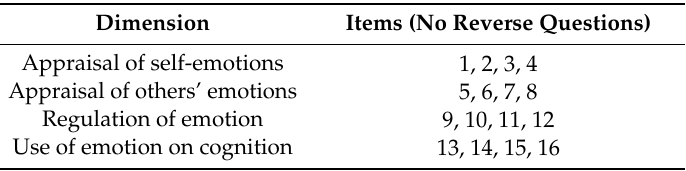
Table 2. Basic information of emotional intelligence scale.